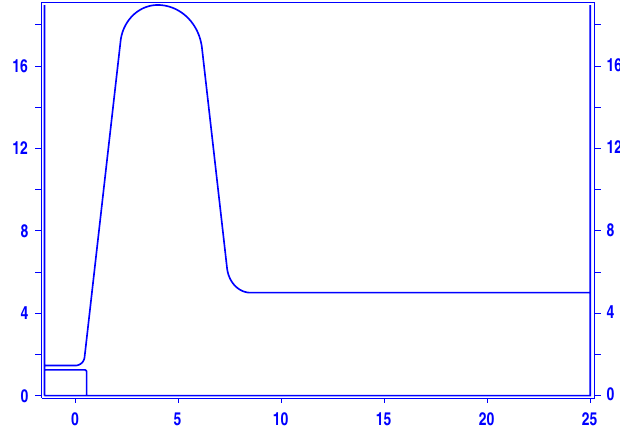
FIG. 1. (Color) SUPERFISH model of the BNL 1 = 2 -cell SRF gun. The horizontal axis corresponds to the gun axis. The vertical axis is the radius. All dimensions are in centimeters. The cathode is at the lower left corner of the figure.